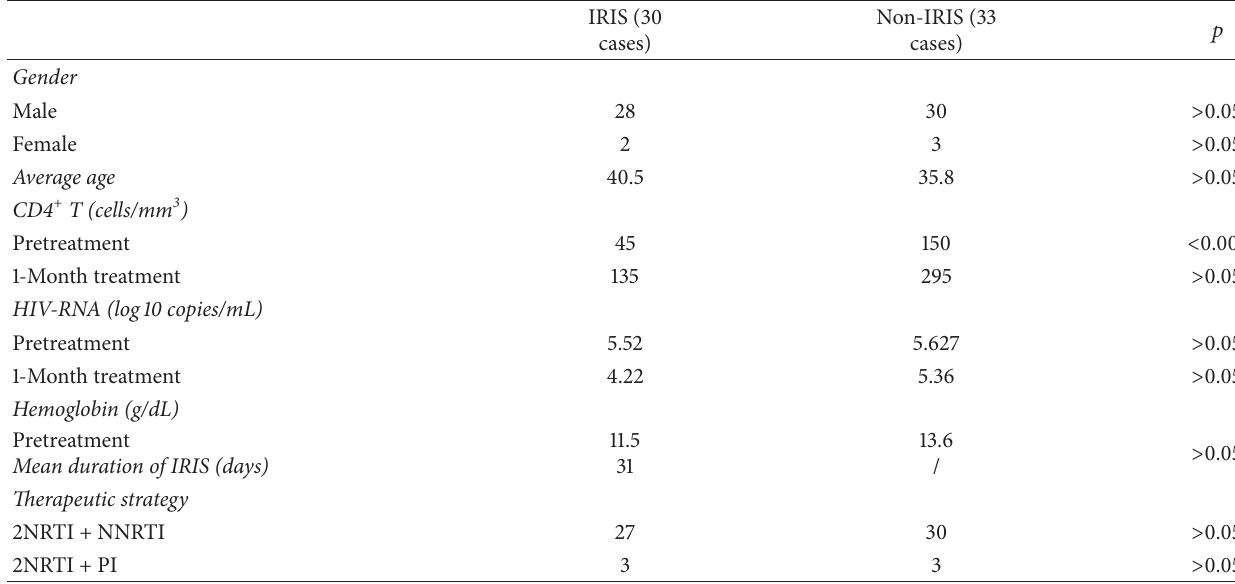
Table 1: General information of the 63 AIDS patients enrolled in this study.